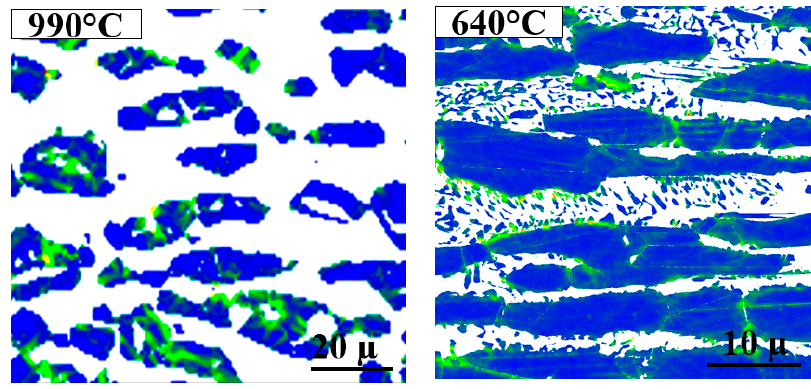
Figure 9. High-resolution γ -LMO maps, where the green areas have higher LMO. γ -LMO is lower in the bulk of primary γ at lower temperatures; however, it is quite high in the γ close to σ /primary γ boundaries.